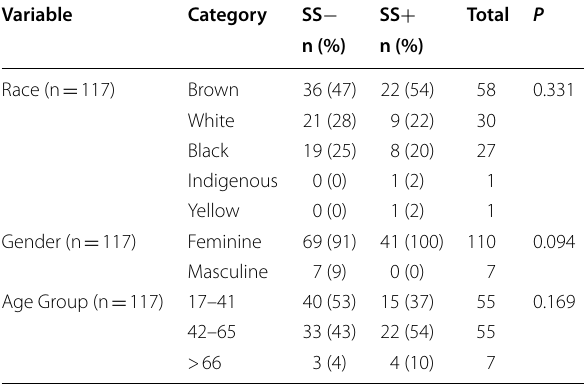
Table 1 Comparison of demographic variables in patients with systemic lupus erythematosus without (SS Sjögren’s